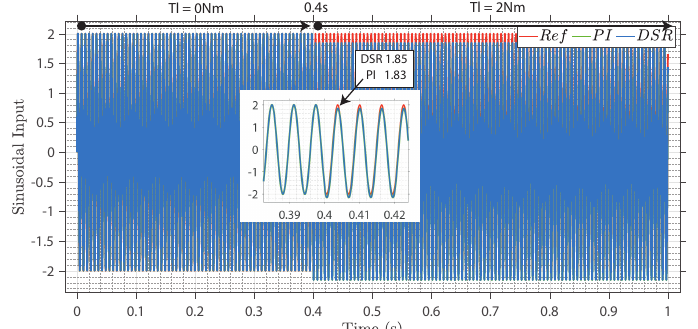
Figure 8. Closed-loop field-orientated control performance: sinusoidal step input. Case